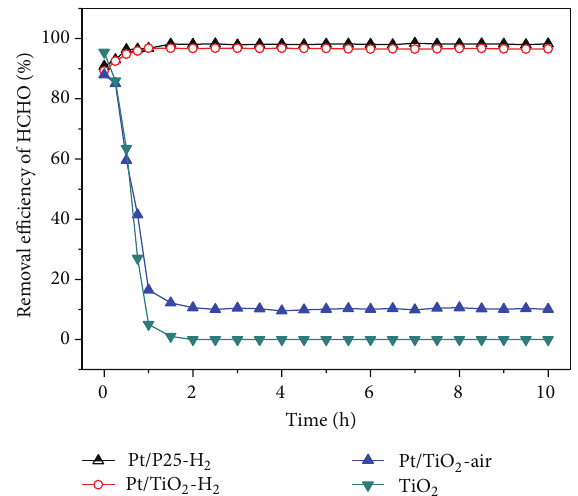
Figure 3: CO 2 concentration at the outlet of reactor.